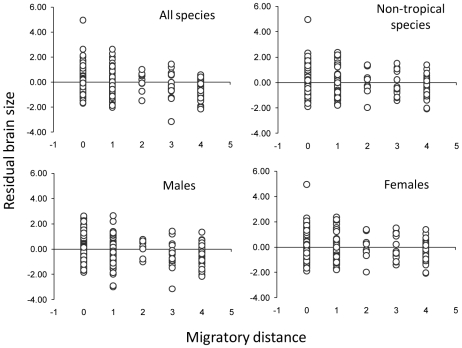
Relationship between brain residual size and migratory distance in passerine birds.A positive brain residual indicates that the species has a brain larger than expected by their body size whereas a negative brain residual indicates that the brain is smaller. Migration has been coded as follows: 0) no populations of species is migratory anywhere in its distribution, 1) altitudinal movements and other movements less than 100 km, 2) movements between 100 and 700 km, 3) 700–1500 km, and 4)>1500 km.